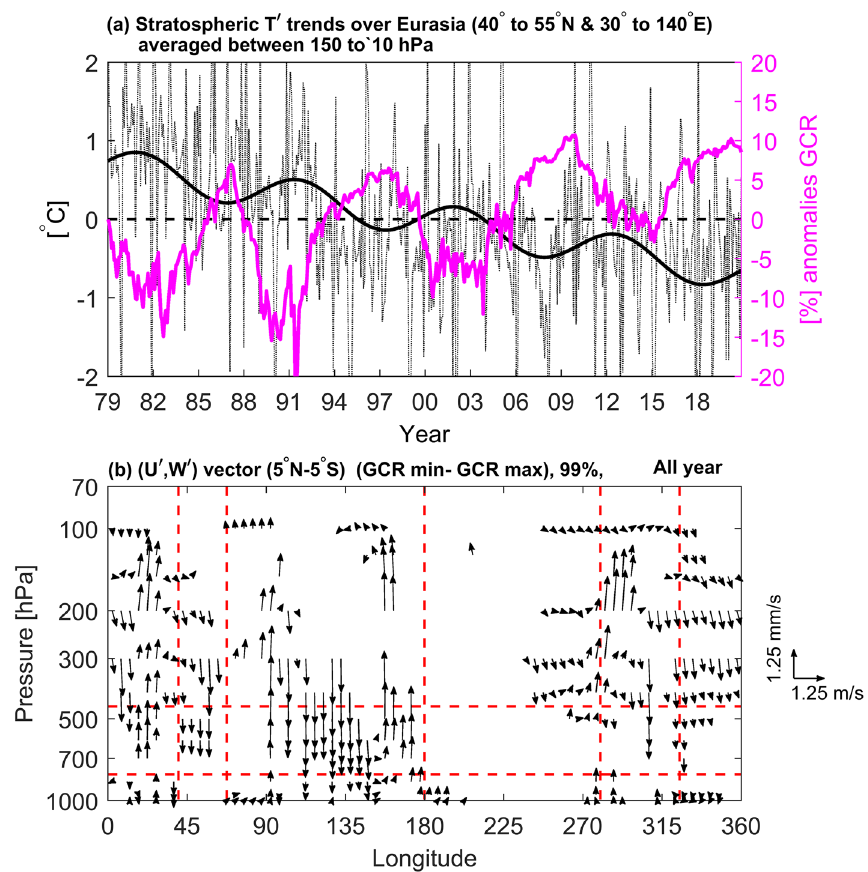
′ Figure 4. ( a ) Monthly time variation of stratospheric T trends (150–50 hPa, dotted curve) over the Eurasia region, where the sold line represents the ideal band-pass filtered data, which allows the signal between 10–12 years periodicity. GCR anomalies are shown with the purple curve. ( b ) The composite difference (GCR ′ ′ min—GCR max group) of zonal mean (U , W ) wind vectors (5°S to 5°N) is plotted, only if either component’s statistical significance exceeds the 99% in the composite